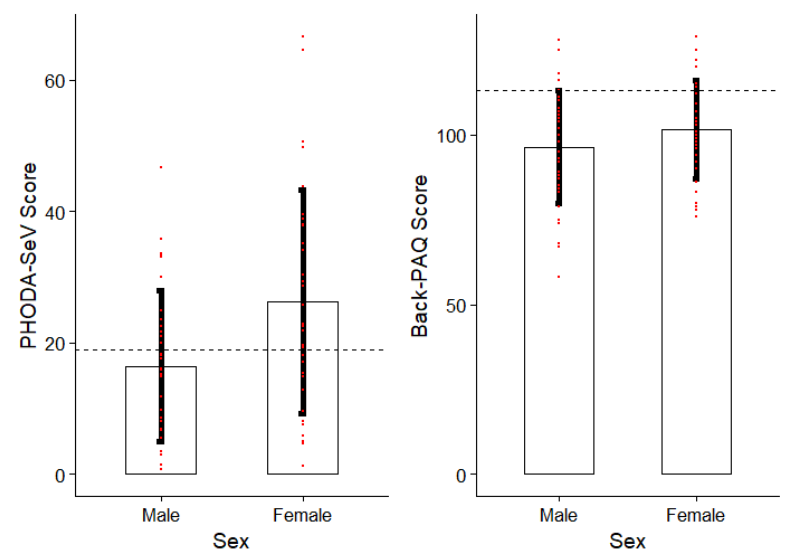
Figure 1. Mean ± Standard Deviation as Error Bars PHODA-SeV and Back-PAQ Scores for Males, Females. Dashed Line Represents General Population Mean Score, and red dots represent individual data points.